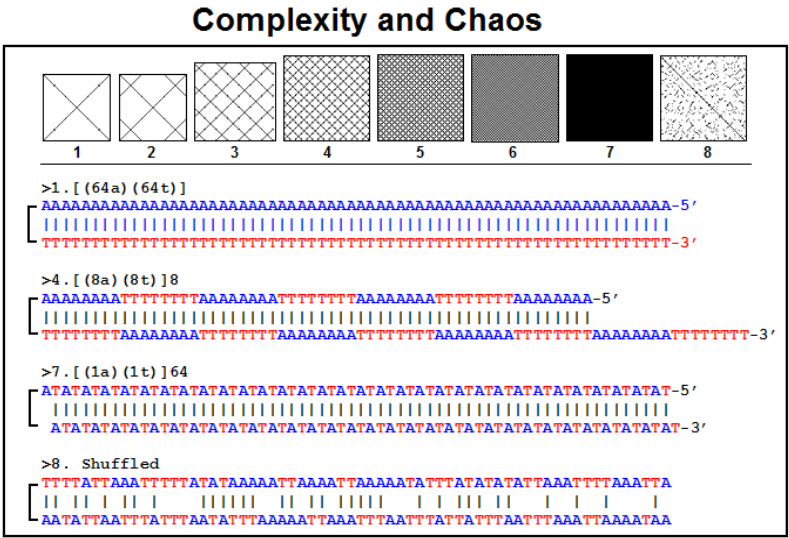
Figure 10. Complexity and chaos. A 128-base sequence contains 64 A and 64 T in regular, alternating arrangements. The altering periods are 64 (1), 32 (2), 16 (3), 8 (4), 4 (5), 2 (6) and 1 (7). Identical and complementary subsequences are visualized by the Dotler tool (diagonal lines in the upper quadrangular areas). The sequences form a hairpin-like structure (mFold method, lower part of the figure). No further shortening of the alternating periods in the sequences is possible (max. complexity in sequence and dotplot is near 7) and the system becomes chaotic